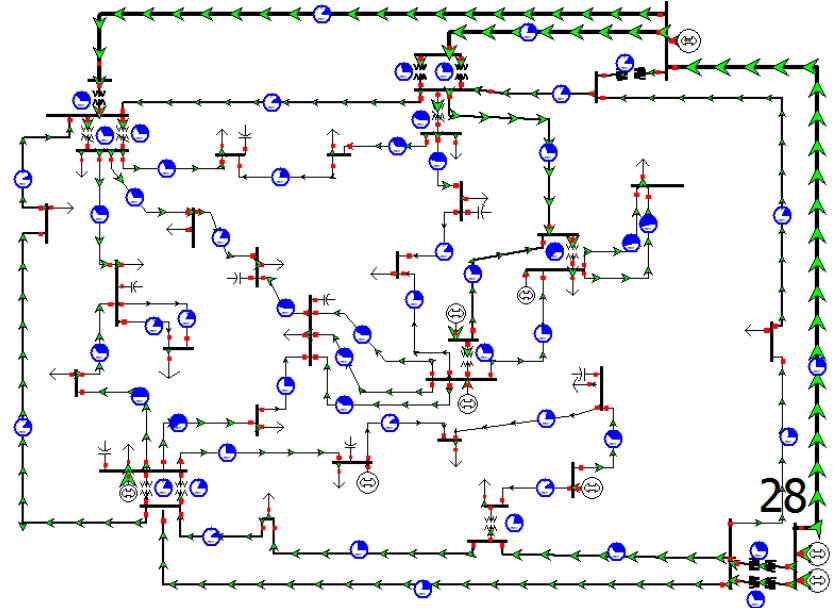
Figure 5. GSO 37-bus